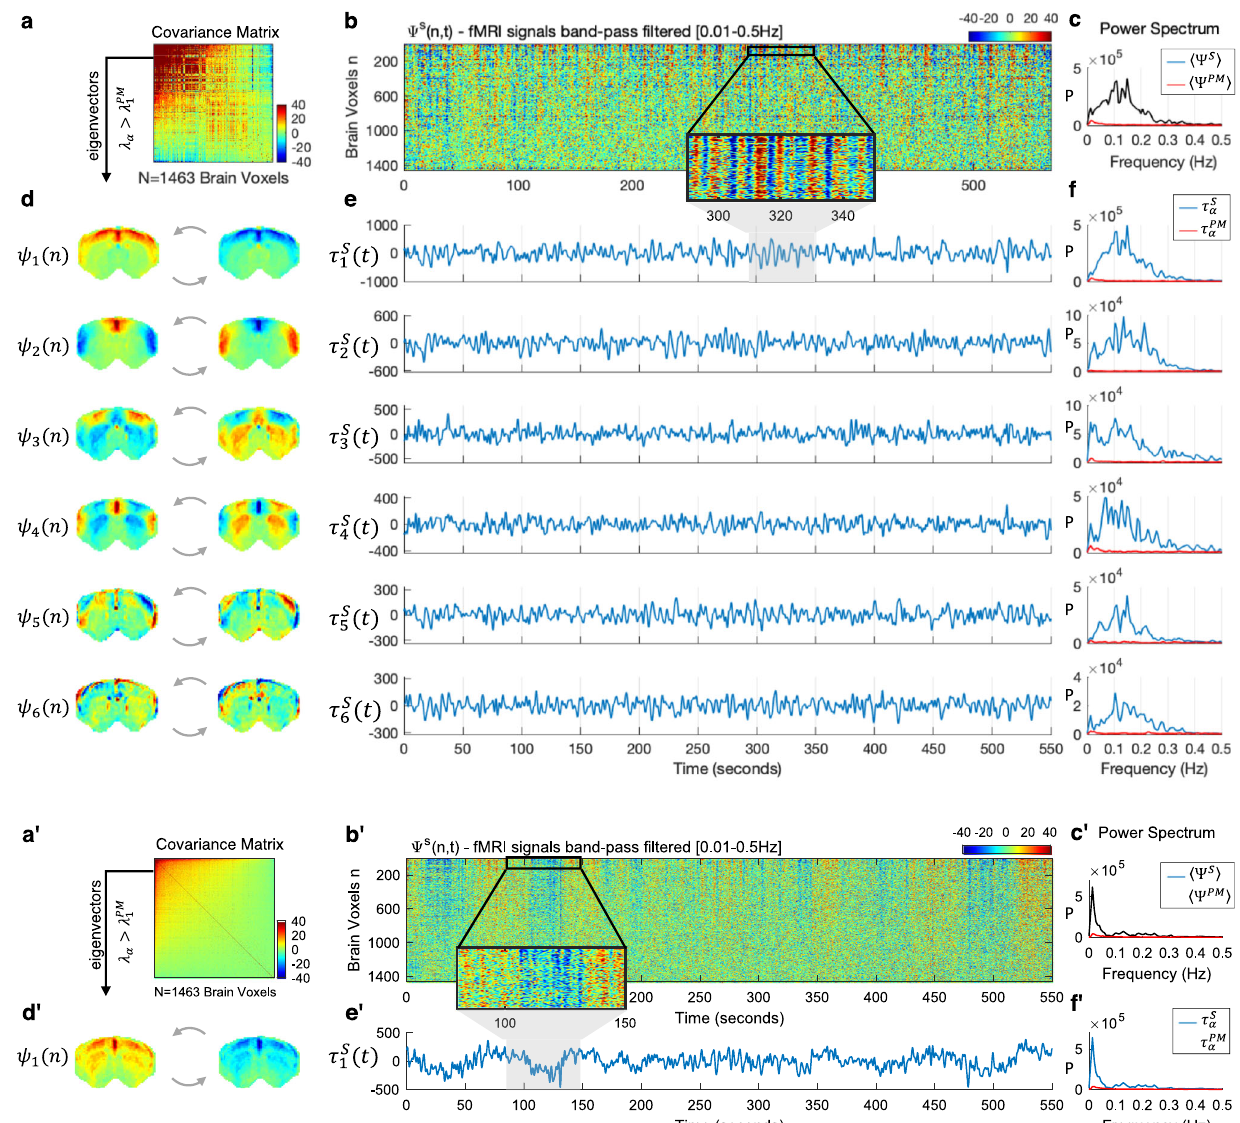
Fig.6|Theadditionofiso fl uraneat1%and3%concentrationsaltersthespatial, temporal, and spectral signatures of principal components. a, a ’ The N × N covariance matrix of fMRI signals band-pass fi ltered between 0.01 and 0.3Hz, averagedacross12scansaftertheadditionofiso fl uraneat1%(top)and3%(bottom) concentrations. b, b ’ Carpet plotof the fMRIsignals recorded inall brainvoxels, n , overtime, t , representedby the wavefunction Ψ S ð n , t Þ , hereshown for two scans S of the same rat from Fig. 3 in the frequency range [0.01 – 0.5Hz]. Voxels are sorted according to the elements in the largest magnitude eigenvector ψ 1 . Values